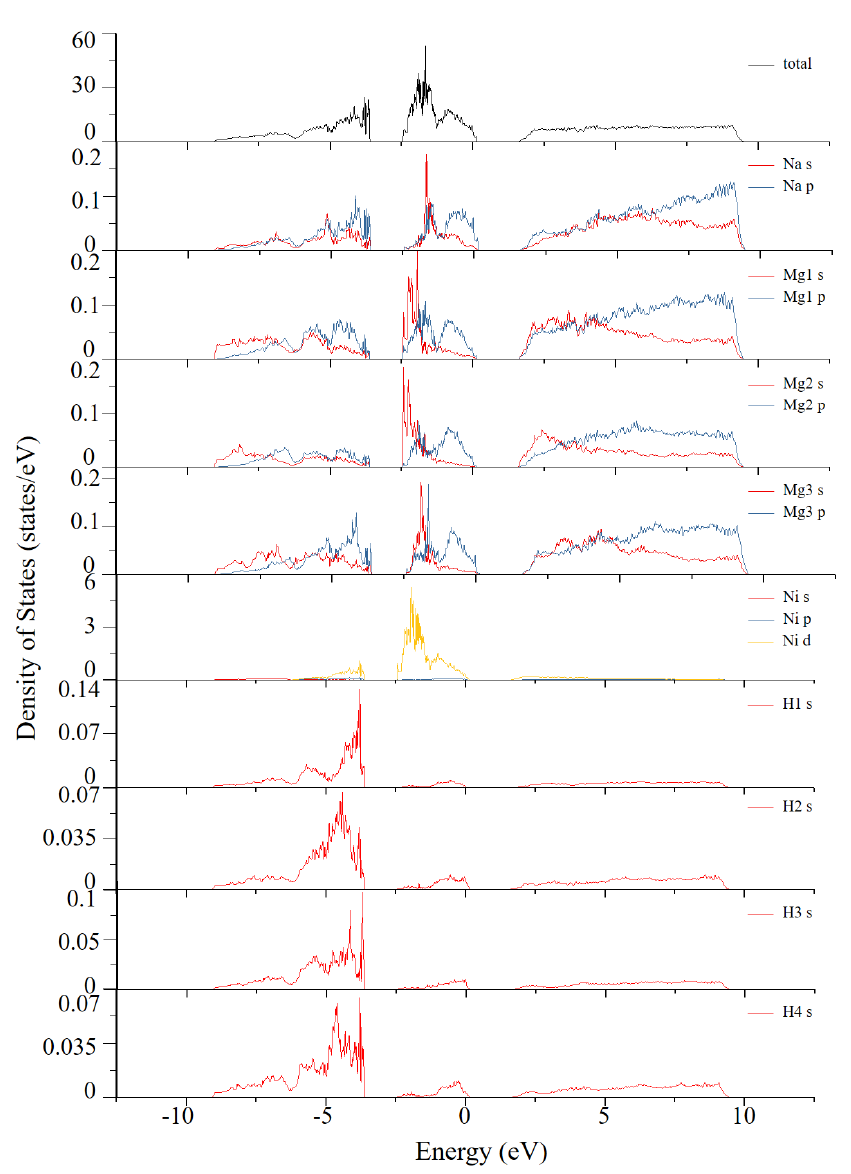
Figure 7. The calculated total and partial electronic density of states (DOS) for the Na-doped Mg 2 NiH 4 solid. The Fermi level is set at